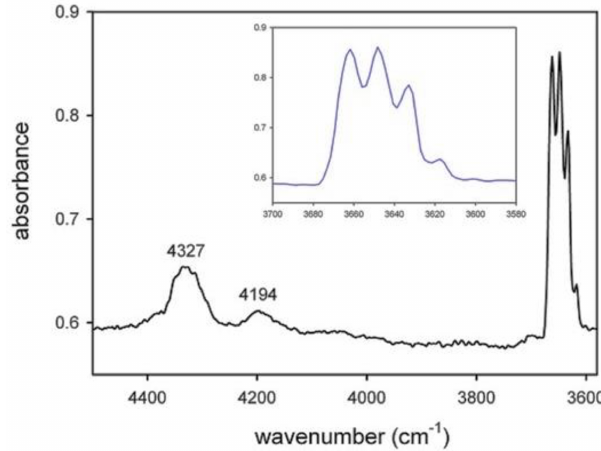
Figure 4. Single-crystal NIR spectrum of the studied glaucophane. The OH-stretching region is magnified in the inset.